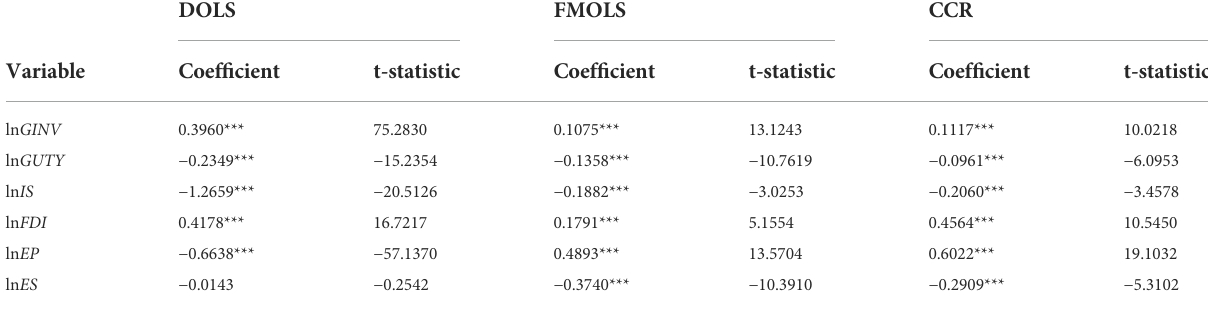
TABLE 5 Long-term estimates of FMOLS, DOLS, and